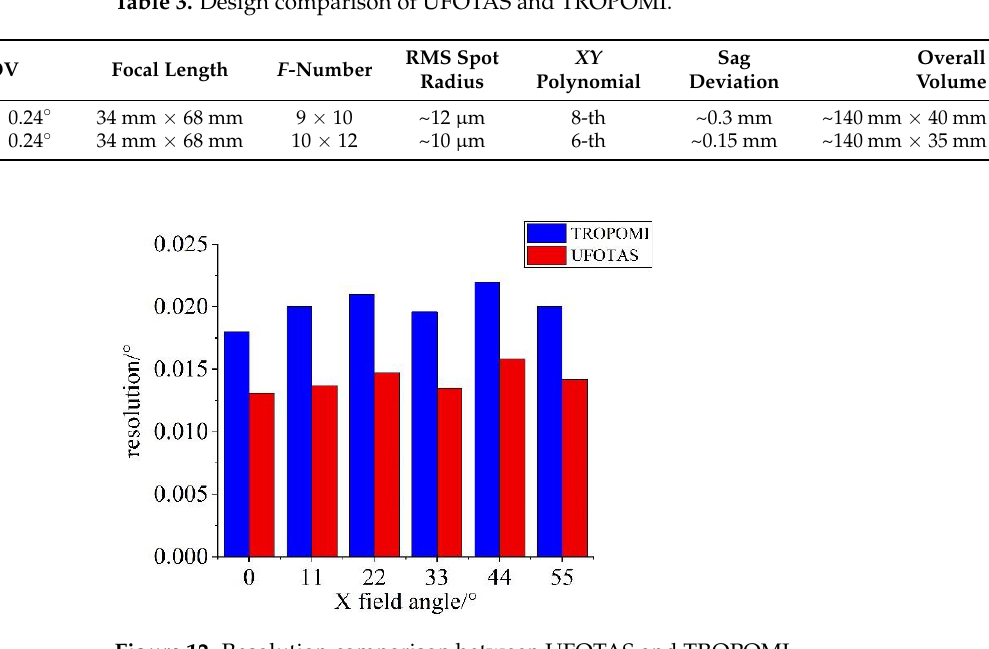
Table 3. Design comparison of UFOTAS and TROPOMI.